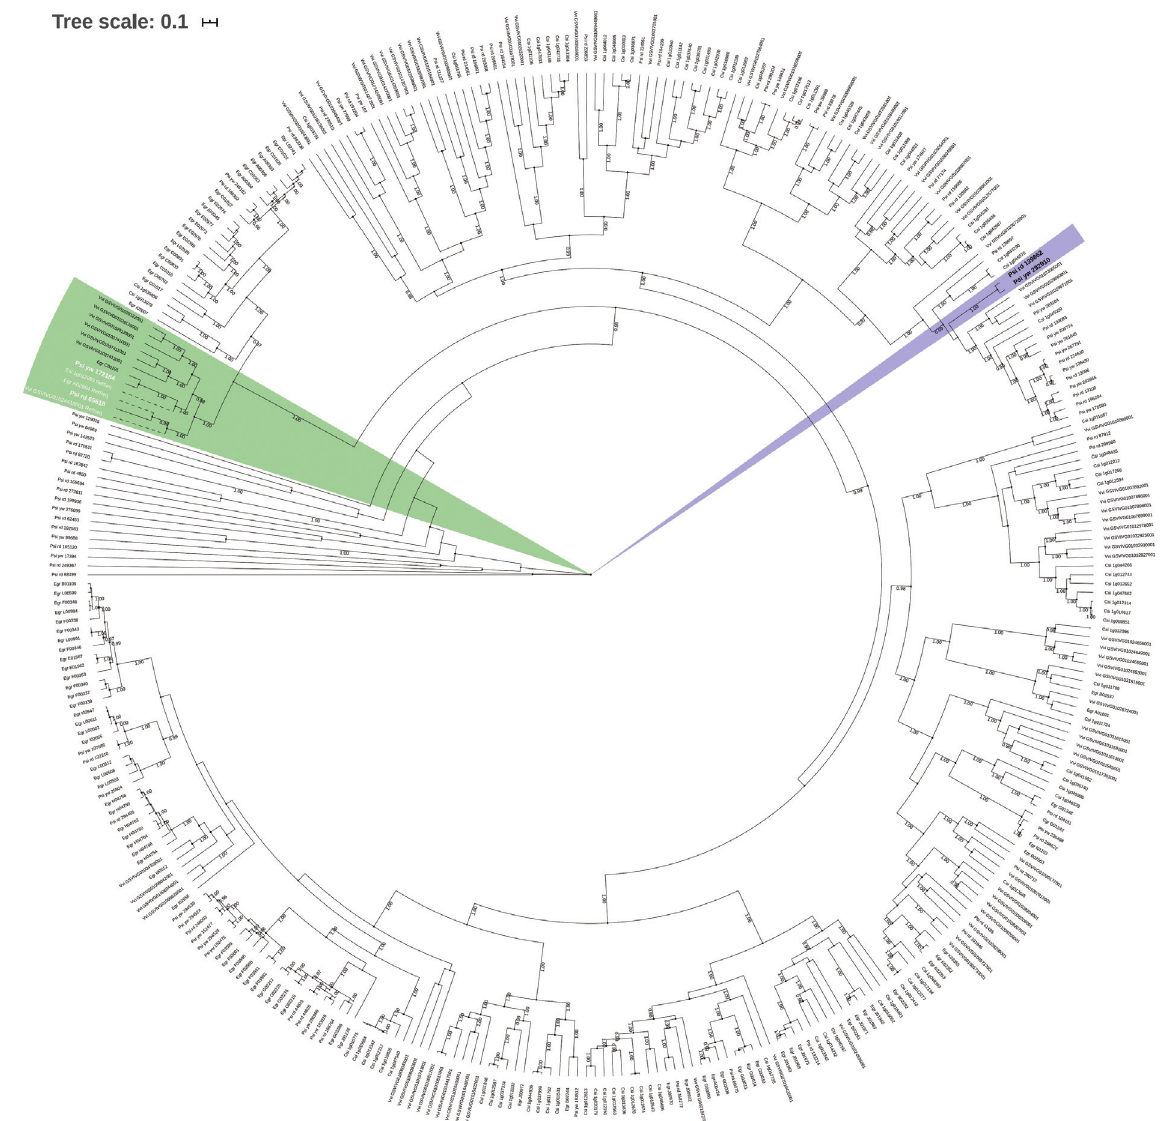
Figure 8 - Phylogenetic analysis showing the putative homologs of UFGT of P. cattleyanum grouped with genes knowns in other species involved with anthocyanin synthesis. The posterior probabilities greater than 0.95 are shown on